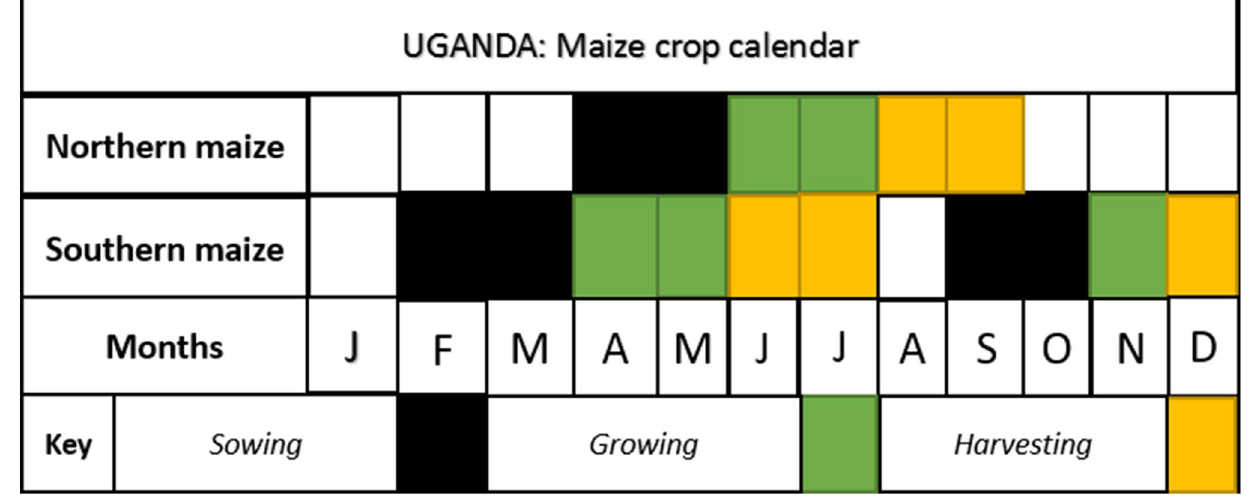
Fig. 1 Maize crop calendar for Uganda. Source : Author’s conceptualization inspired from; FAO